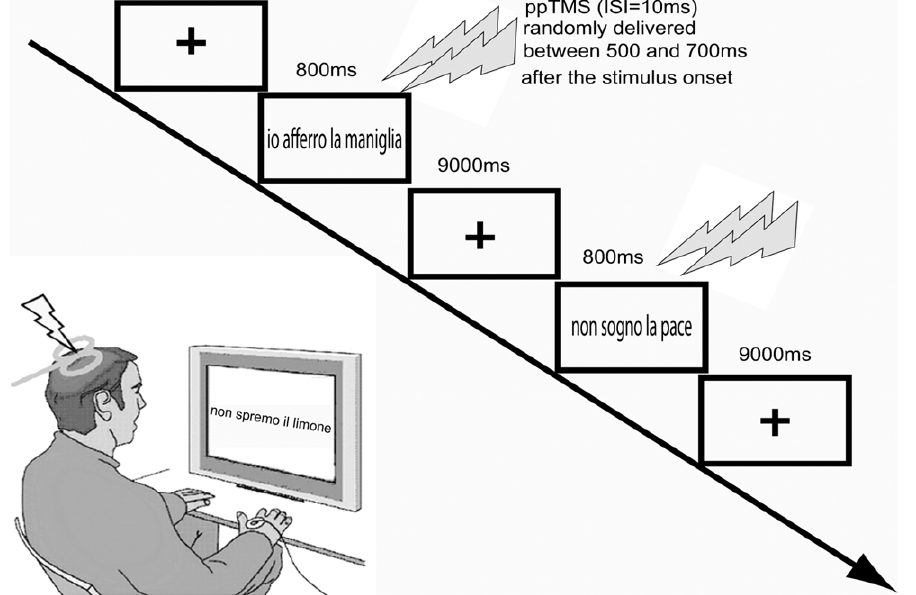
Figure 1. Experimental Procedure. Timeline and subjects’ posture during the experimental procedure. Paired-pulse Transcranial Magnetic Stimulation (p-pTMS) was delivered on average 600 ms ( 6 100 ms) after each sentence appeared on the screen. Stimulation intensity was based on individual resting motor threshold (rMT) for the first dorsal interosseous (FDI). The Conditioning Stimulus (CS) was set at an intensity of 80% of rMT while the Test Stimulus (TS) at 120% of rMT with an Inter Stimulus Interval (ISI) of 10 ms over FDI Optimal Scalp Position